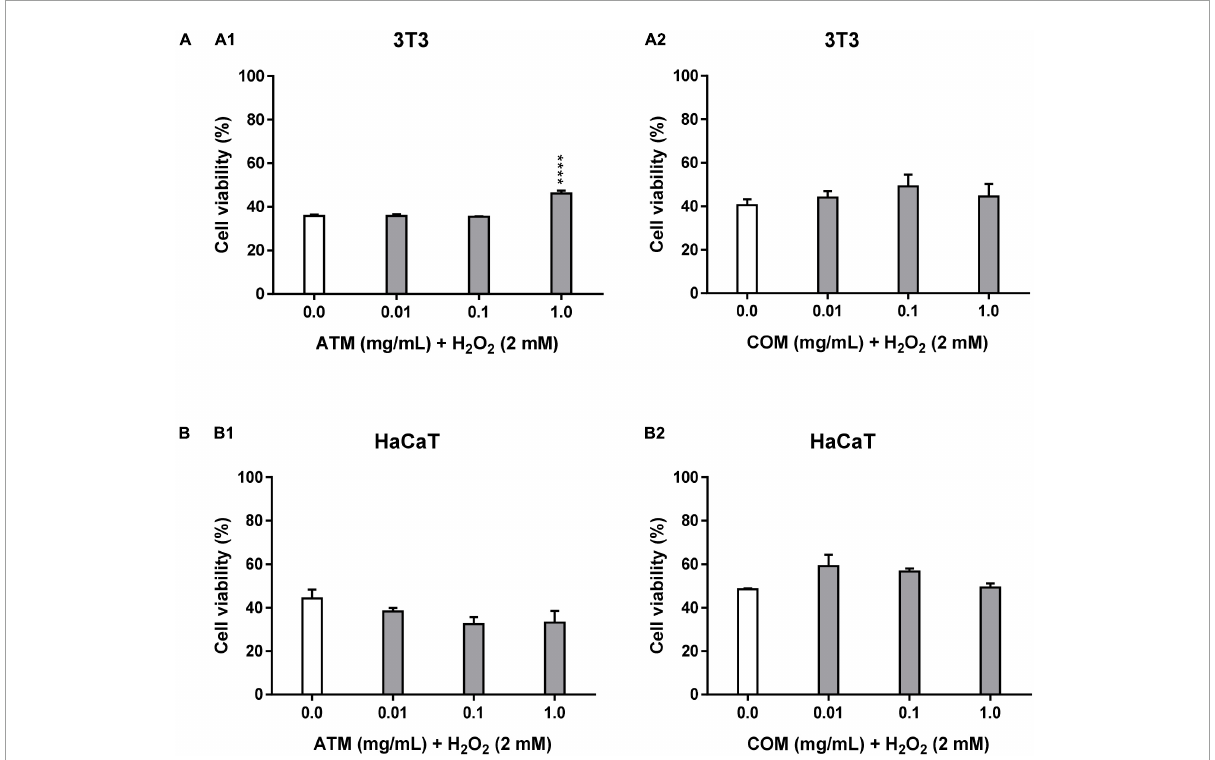
FIGURE2 Cytoprotective activity of ATM (1) and COM (2) in 3T3 (A) and HaCaT (B) cell lines for 2 mM H 2 O 2 during 2.5 h by MTT assay and expressed as a percentage of cell viability with respect to untreated cells control. H 2 O 2 cell viability was used as a positive control. Results are expressed as mean ± standard error of n = 3 (3T3) and n = 2 (HaCaT). A two-way analysis of variance (ANOVA) and a Bonferroni post hoc assay have been performed. Statistical differences were considered as follows: **** p ≤ 0.0001 comparison with positive control.